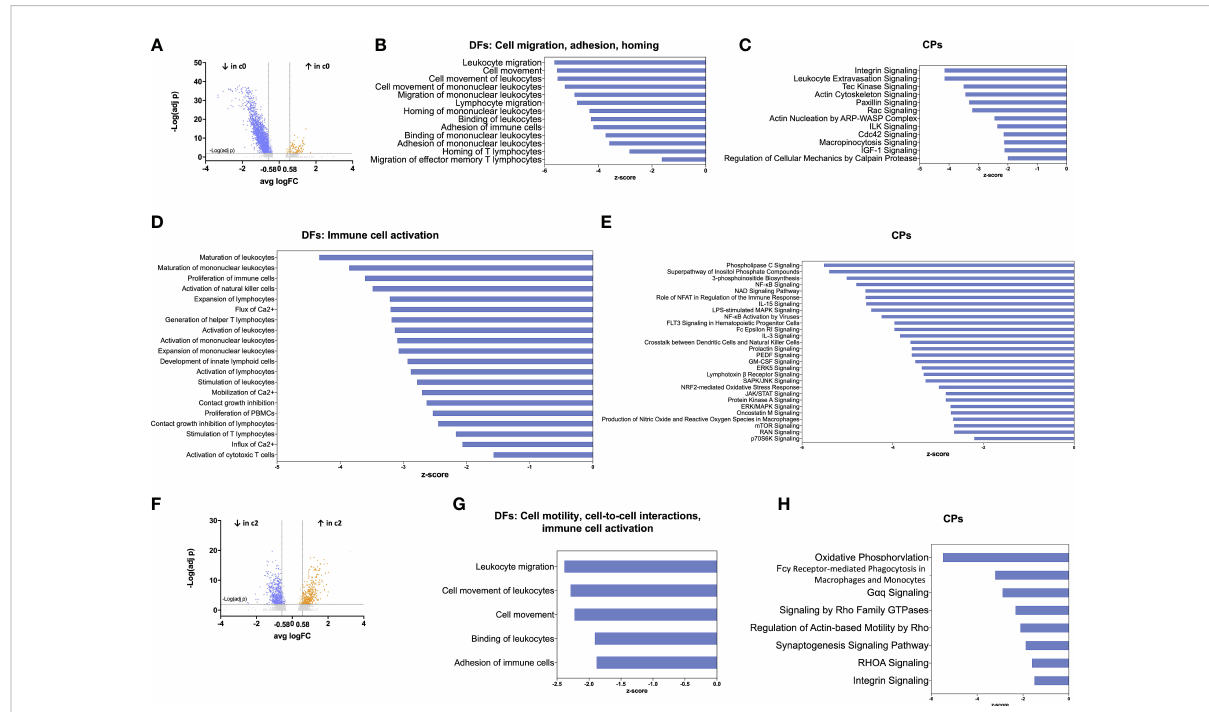
FIGURE 4 Functional annotation of TIDC clusters by IPA analysis reveals impairment of the largest cluster of DCs. (A) Volcano plot showing DEGs between cluster 0 (the largest cluster of TIDCs) and cluster 1, at resolution 0.3. Grey dots indicate genes that were not statistically signi fi cant (p adj >0.01); orange dots indicate signi fi cantly up-regulated genes (with log 2 FC>0.58), and blue dots indicate signi fi cantly down-regulated genes (with log 2 FC<-0.58). (B) Bar plot showing DFs of sub-categories related to cell migration, adhesion and homing that were signi fi cantly down- regulated in cluster 0 compared with cluster 1. (C) Bar plot showing CPs related to DFs shown in b that were signi fi cantly down-regulated in cluster 0 compared with cluster 1. (D) Bar plot showing DFs related to immune cell activation that were signi fi cantly down-regulated in cluster 0 compared with cluster 1. (E) Bar plots showing CPs related to DFs shown in D that were signi fi cantly down-regulated in cluster 0 compared with cluster 1. (F) Volcano plot showing DEGs between cluster 2 (mostly composed of cells deriving from dex-treated patients) and cluster 0, at resolution 0.3. Grey dots indicate genes that were not statistically signi fi cant (p adj >0.01); orange dots indicate signi fi cantly up-regulated genes (with log 2 FC>0.58), and blue dots indicate signi fi cantly down-regulated genes (with log 2 FC<-0.58). (G) Bar plot showing DFs of sub-categories related to cell motility, cell-to-cell interactions, and immune cell activation that were signi fi cantly down-regulated in cluster 2 compared with cluster 0. (H) Bar plots showing CPs related to DFs shown in G that were signi fi cantly down-regulated in cluster 2 compared with cluster 0. In all the bar plots, the functions or pathways, listed on the left side of the plot, are ranked according to the z-score that predicts a down- regulation (blue, z-score